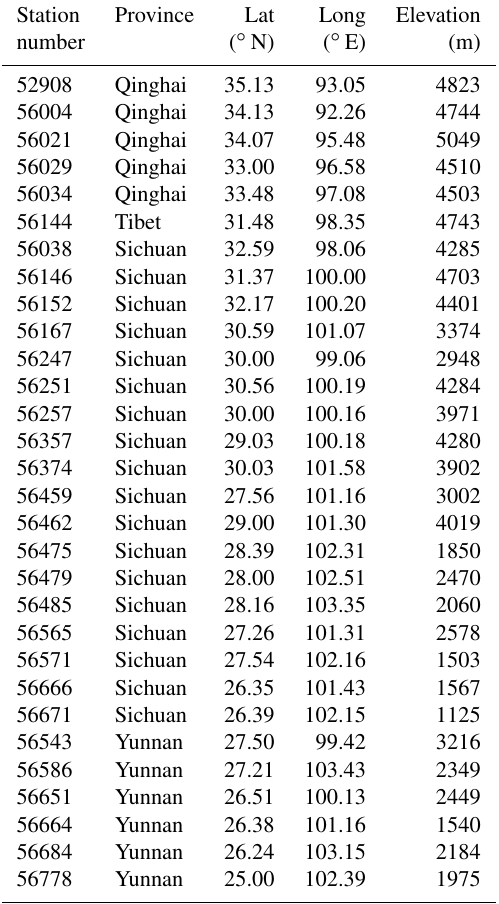
Table A1. Geographical characteristics of the rain